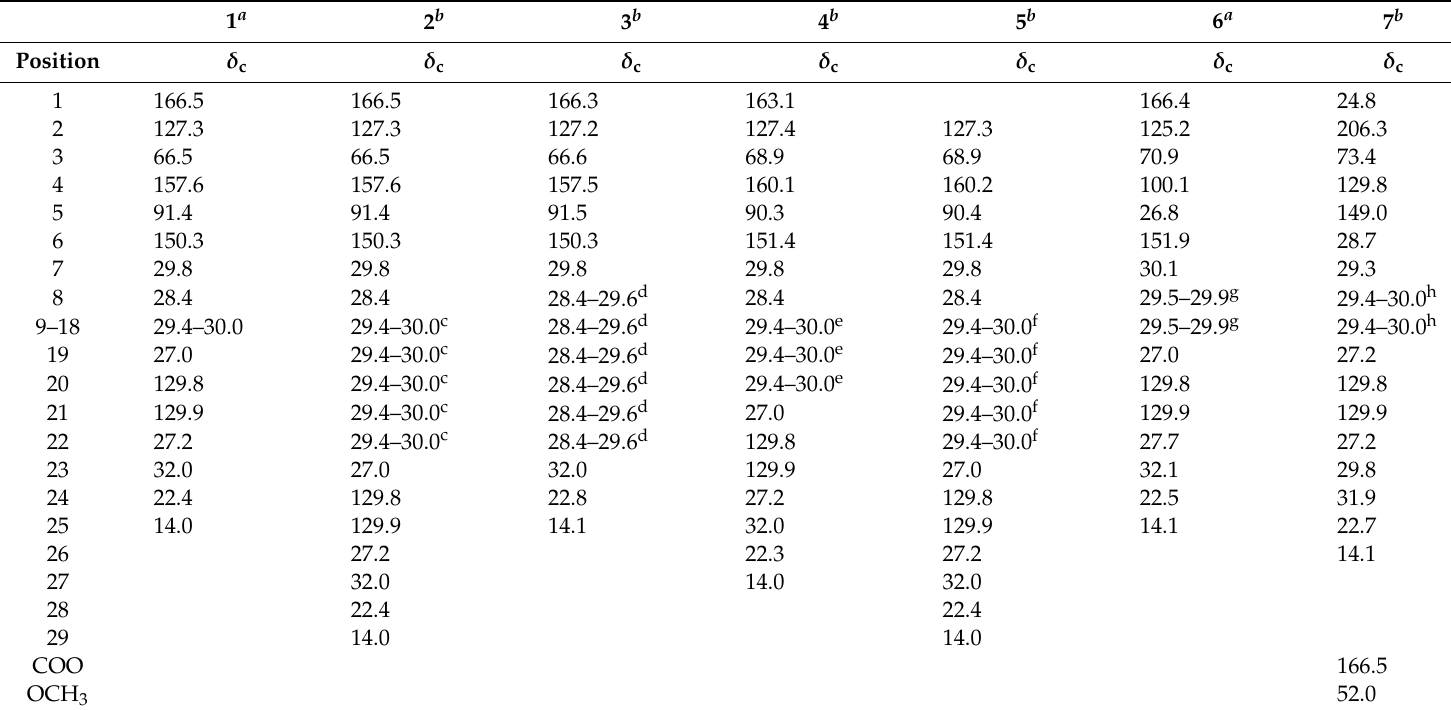
Table 2. 13 C NMR Spectroscopic data in CDCl 3 of compounds 1 − 7